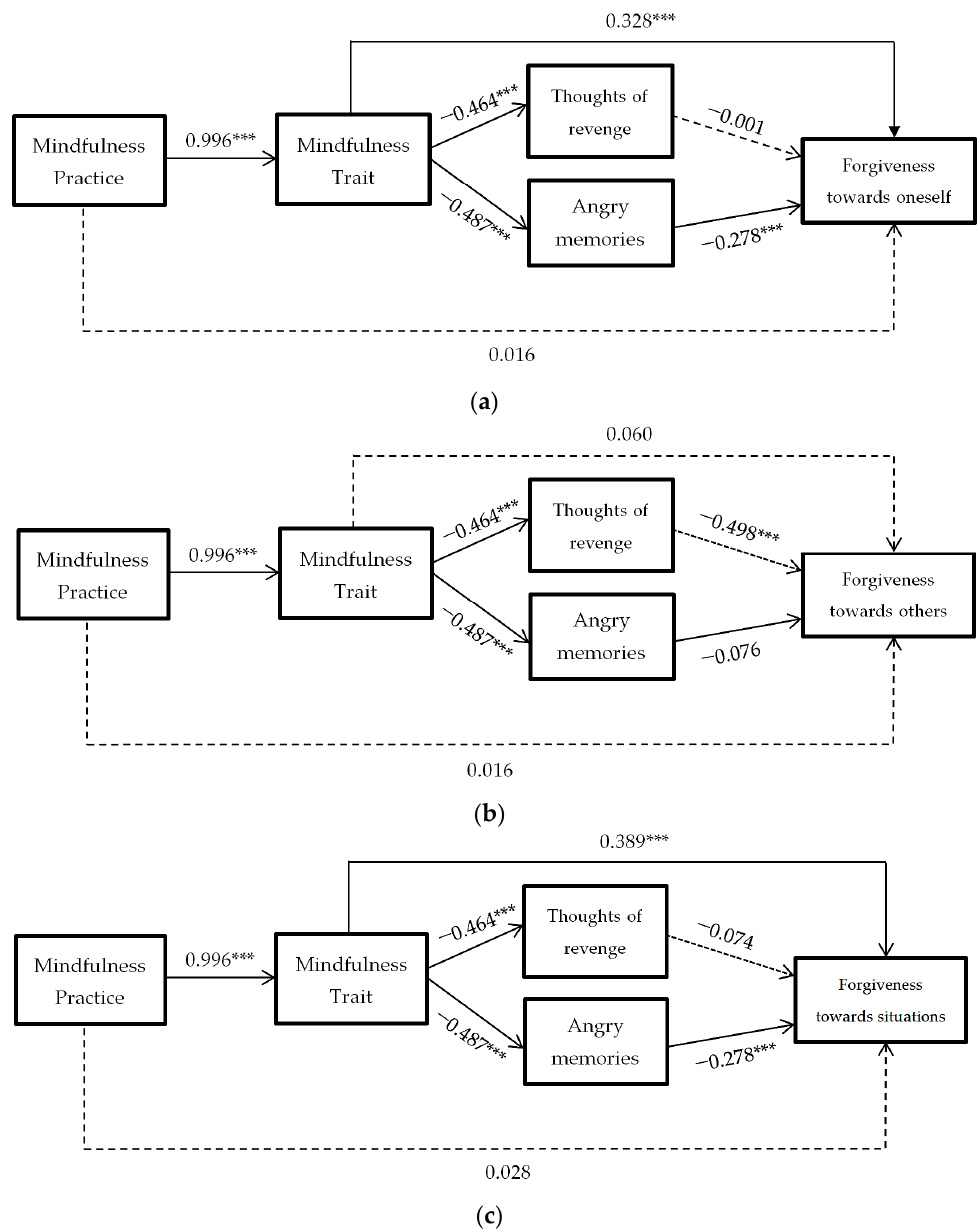
Figure 4. Hypothesized mediation model: spillover effect of mindfulness practice on forgiveness to oneself ( a ), to others ( b ) or to situations ( c ) through mindfulness trait, and thoughts of revenge and angry memories. *** = p < 0.001